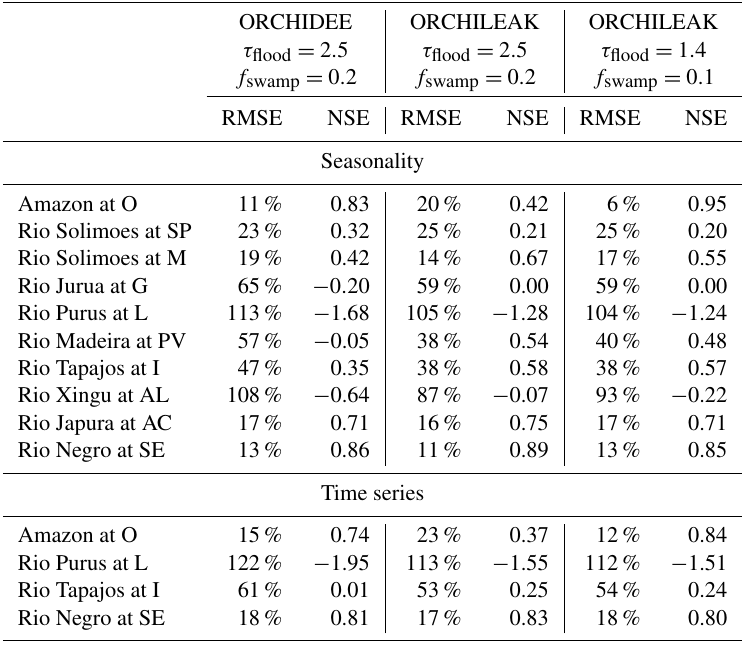
Table 3. Performance of discharge simulations in the trunk version of ORCHIDEE (parametrization by Guimberteau et al., 2012) versus ORCHILEAK. In addition, it is shown how ORCHILEAK would perform with the τ flood = 2 . 5 and f swamp = 0 . 2 used in Guimberteau et al. (2012). As performance measures, the RMSE and Nash–Sutcliffe efficiency (NSE) are reported ∗ . In most cases, only the performance in reproducing the seasonality is reported, as it is presented in Fig. 10. For 4 stream gauges with time-series data, the performance in reproducing these time series is additionally reported. For locations and full names of gauging stations, see Fig. 4 and its